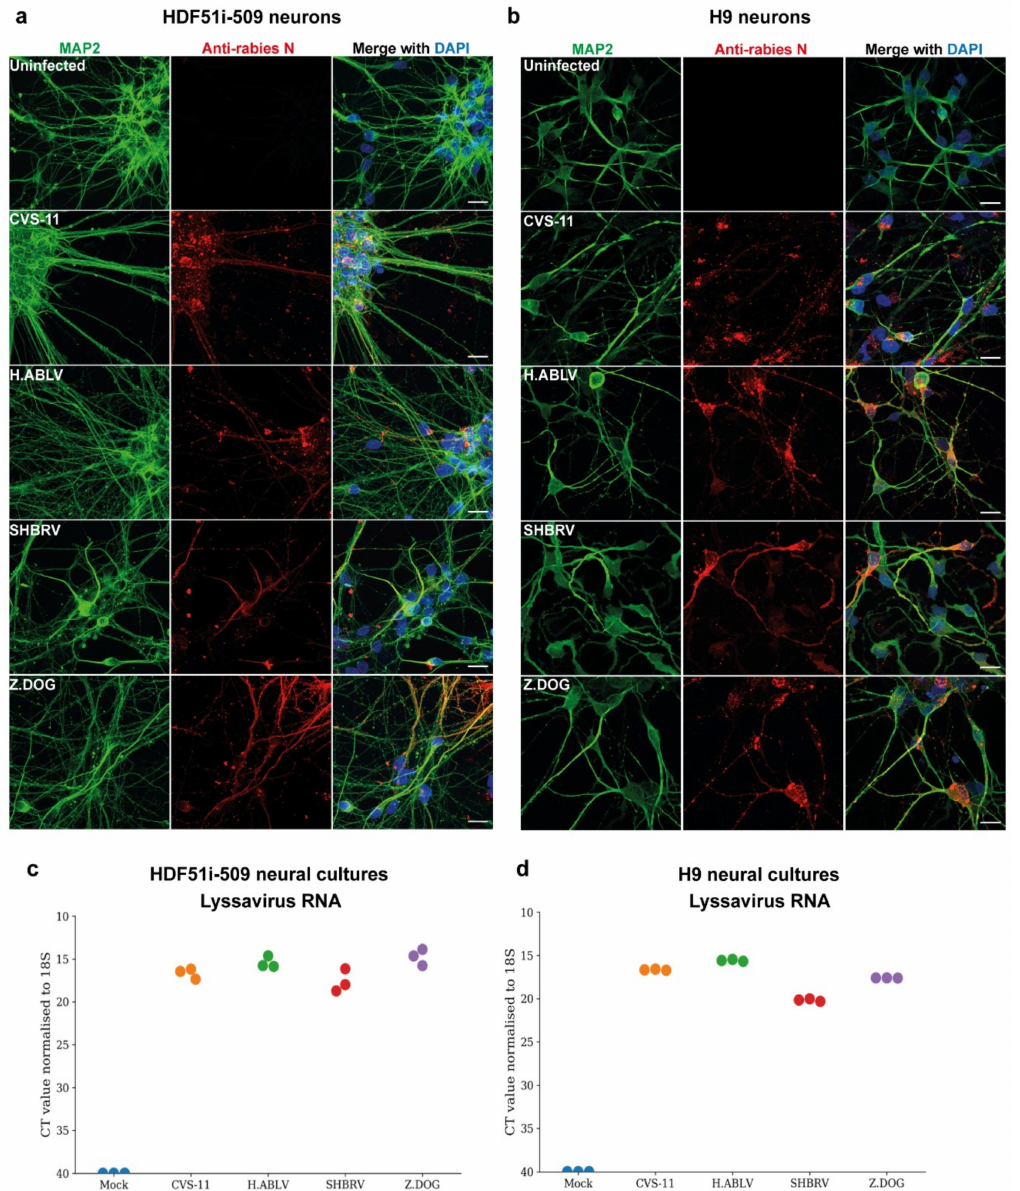
Figure 2. Lyssavirus infection of stem cell-derived human neural cultures. ( a ) HDF51i-509-NPCs and ( b ) H9-NPCs were di ff erentiated for 21 days and 29 days, respectively. Di ff erentiated neural cultures were then infected with di ff erent lyssavirus strains (CVS-11, H.ABLV, SHBRV and Z.DOG) at a virus:cell ratio of 1 for 72 h. Representative images show infection of ( a ) HDF51i-509-NPC-derived and ( b ) H9-NPC-derived neural cultures immunostained for detection of MAP2-positive neurons (green) and rabies virus antigen by anti-nucleoprotein staining (red). Nuclei stained with DAPI (blue), shown as a merged image with red and green channels. Scale bar 50 µ m (images are maximum intensity projection of Z-stacks). ( c , d ) Validation of viral infection shown by qPCR analysis of lyssavirus RNA in ( c ) HDF51i-509-NPC- and ( d ) H9-NPC-derived neural cultures, n =